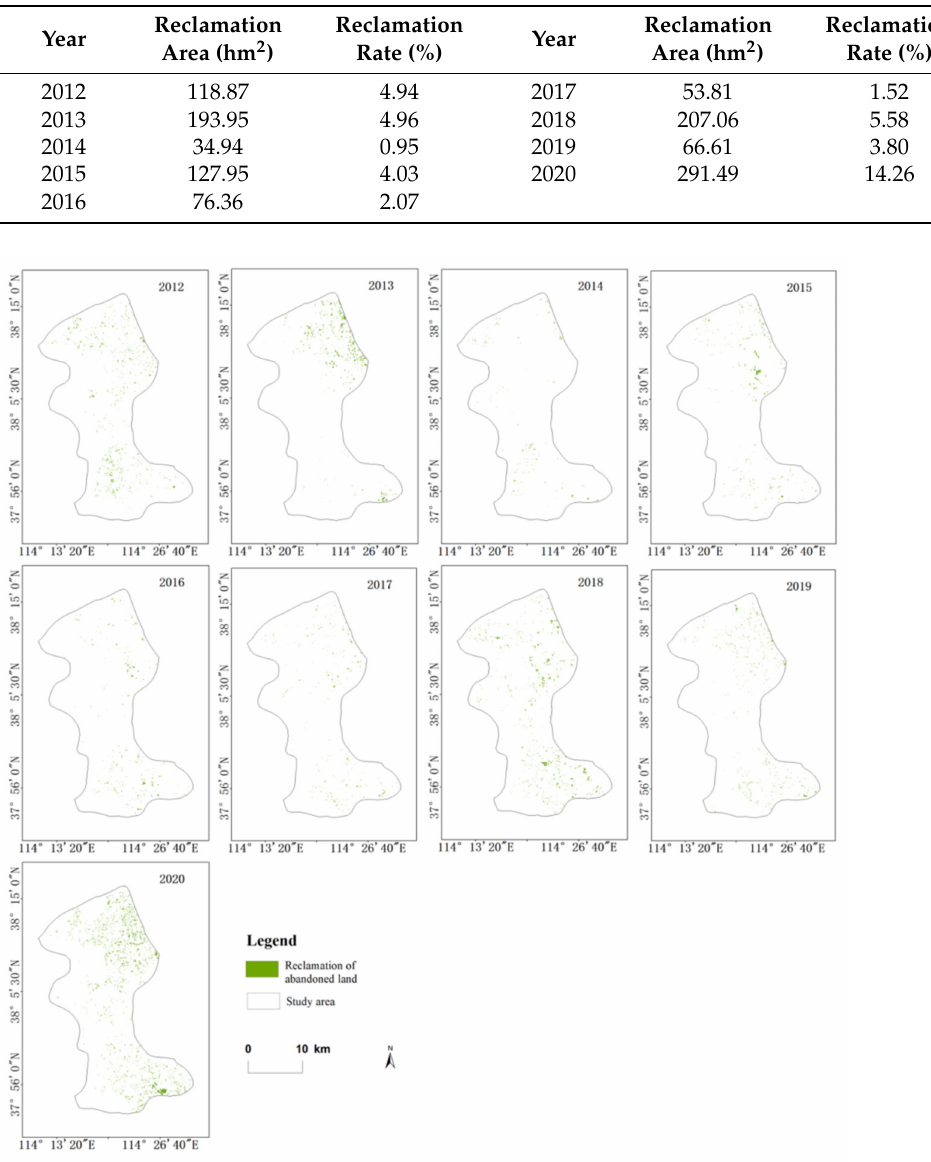
Figure 8. Re-cultivation time-series distribution map in Luquan for the period of